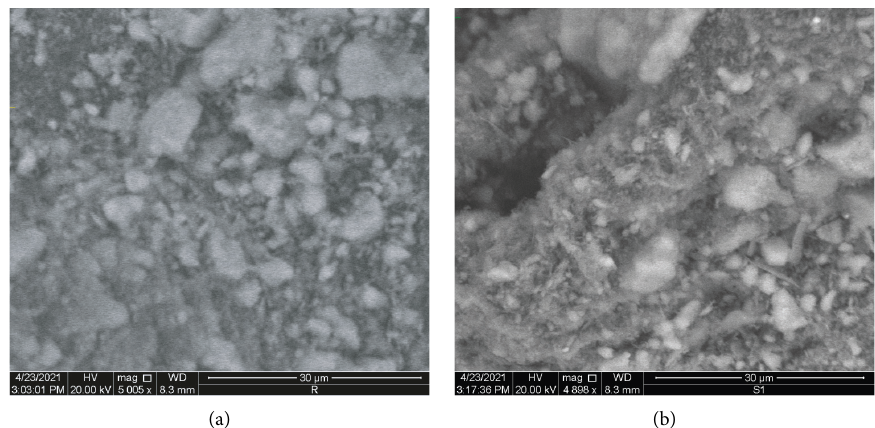
Figure 6: SEM micrographs of (a) kaolinite and (b) Table 2: The comparison of Ethiopian kaolinite pozzolanic activity and specific surface area with the literature. Origins of kaolinite